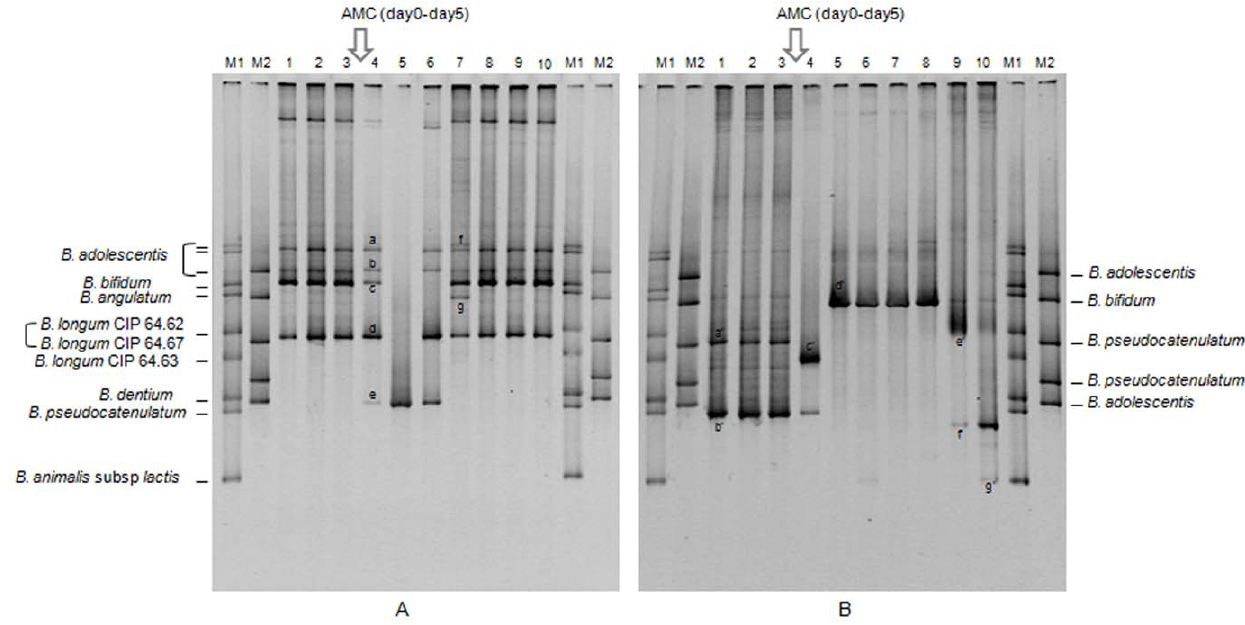
Figure 4. TTGE profiles representing the bifidobacterial diversity of fecal samples from two healthy volunteers (A and B) before and after AMC exposure. 1:day-12; 2:day-6; 3:day 0; 4:day 5; 5:day 8; 6:day 12; 7:day 19; 8:day 26; 9:day 33; 10:day 64. a, b, d, e, f, a 9 : B. adolescentis ; c, g: B. bifidum ; b 9 : B. pseudocatenulatum ; c 9 : B. longum ; d 9 : B. dentium ; e 9 : B. breve ; f 9 : B. pseudolongum ; g 9 : B. animalis subsp. lactis .